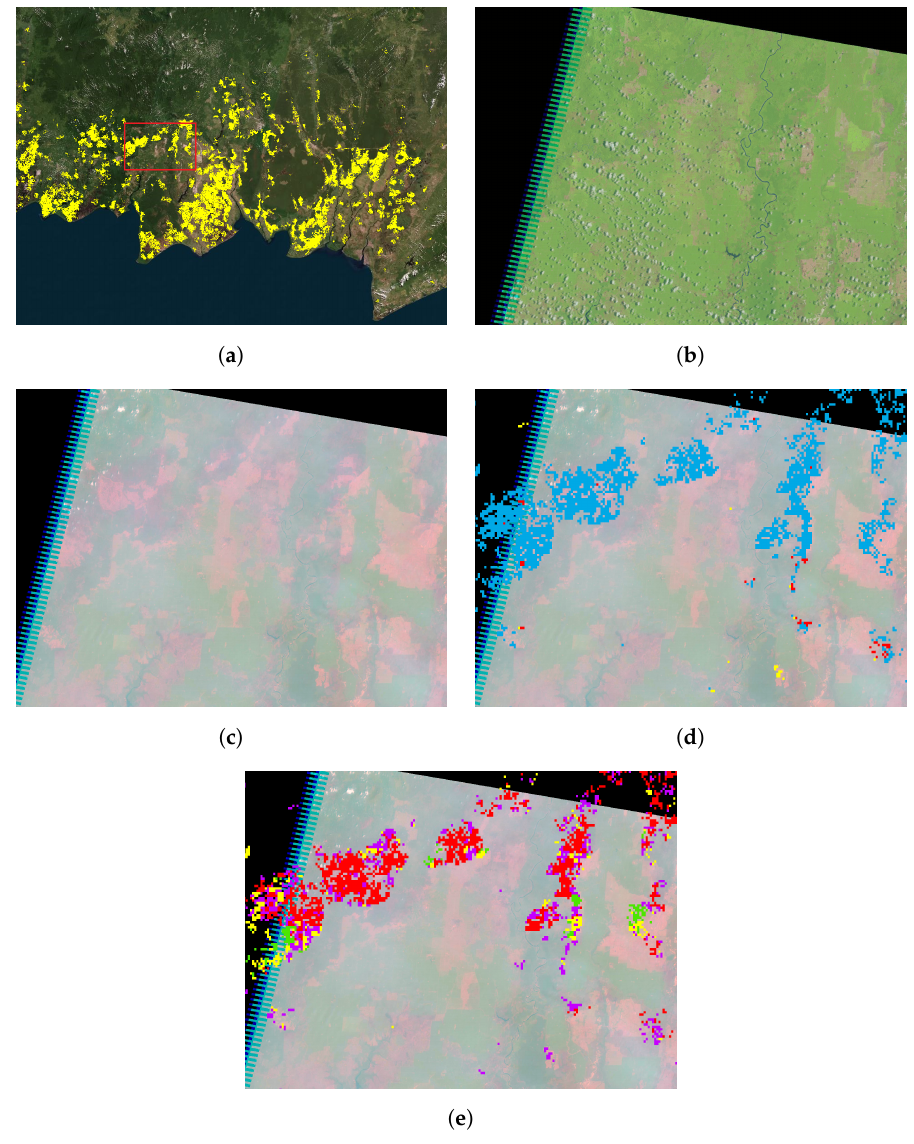
Figure 4. Figure shows a region in Indonesia where RAPT identified several burned pixels missing in MCD64. Figure also shows the data quality as provided by MCD64 product around the burn date for the identified burned pixels. ( a ) Burned area (in yellow) in a region of SE Asia. The red rectangle is the focus area for this figure; ( b ) Before burn Landsat 5 image on 10 March 2006; ( c ) After burn Landsat 5 image on 5 November 2006; ( d ) Burned area comparison map ( blue is only RAPT, red is common, yellow is only MCD64); ( e ) Color coded quality map according to MCD64 bit 1 flag ( red is 0/3 time steps with good quality, purple is 1/3 time steps with good quality, yellow is 2/3 time steps with good quality, green is 3/3 time steps with good